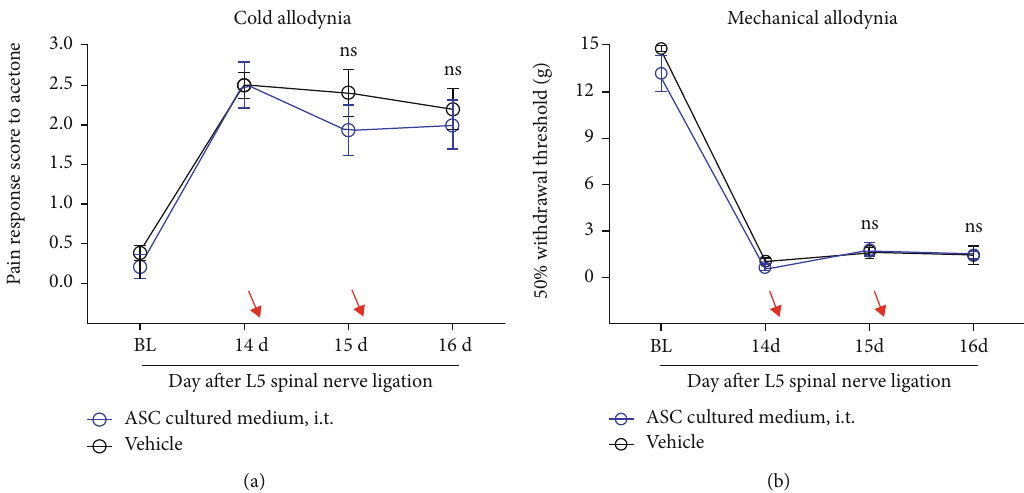
Figure 4: Absence of the analgesic e ff ect following the injection of ASC-derived culture medium on the rat model with L5 spinal nerve ligation. (a, b) No e ff ects observed on mechanical allodynia (a) and cold allodynia (b) by treatment with ASC-derived culture medium after the L5 spinal nerve ligation surgery. Arrows indicate time of injection (POD 14, POD 15). p > 0 : 05 , compared with vehicle (30 μ l DMEM); n = 5 − 7 rats/group. p > 0 : 05 , compared with POD14. All data are expressed as the mean ± SEM . Statistical signi fi cance was determined by 2-way ANOVA, followed by Sidak ’ s posthoc test. ns: not signi fi cant; POD: postoperative day; BL: baseline; i.t.: intrathecal injection; ASC: adipose tissue-derived stem cell; DMEM: Dulbecco ’ s modi fi ed Eagle ’ s high-glucose